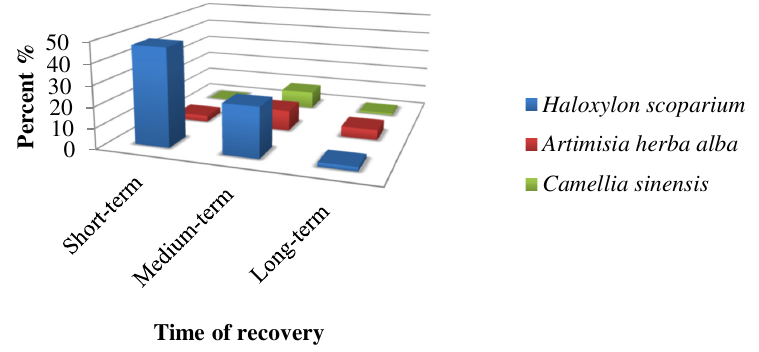
Figure 6. Recovery time of patients treated with medicinal preparations of Haloxylon scoparium , Artemisia herba-alba , and Camellia